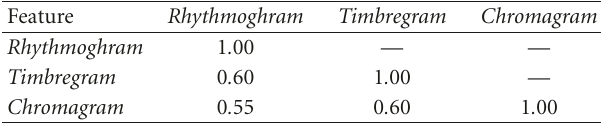
Table 1: F 1 of the total database for comparison between the seg- mentation using the rhythmogram , timbregram , and chromagram .